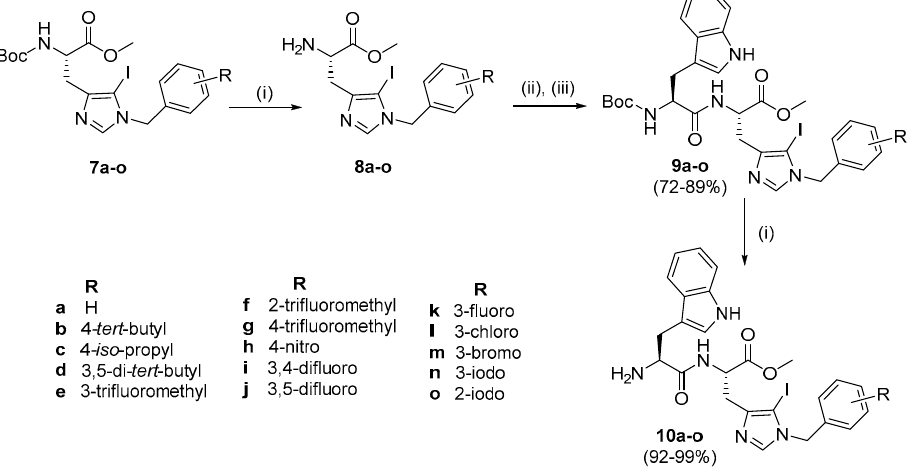
Figure 2. N- benzylated 5-iodohistidine derivatives. Figure 2. N -benzylated 5-iodohistidine derivatives.